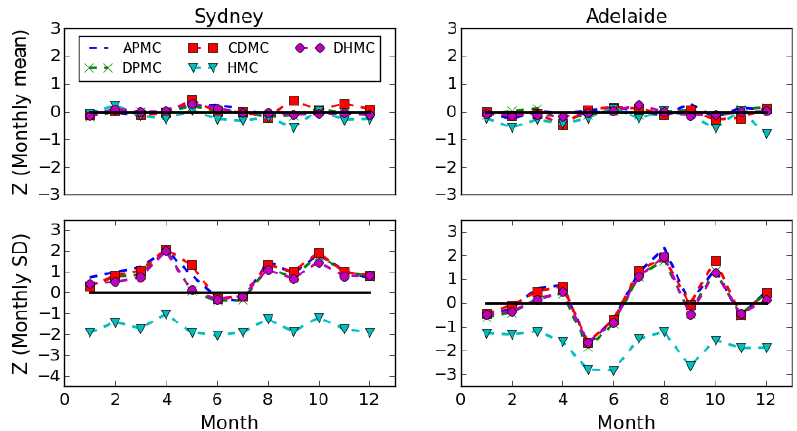
Figure 10. Comparison of the mean and SD of monthly number of wet days for the five MC